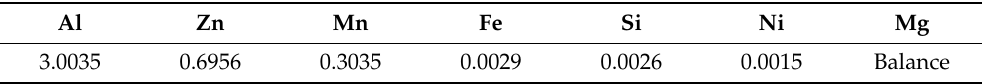
Table 1. Chemical composition of AZ31 alloy